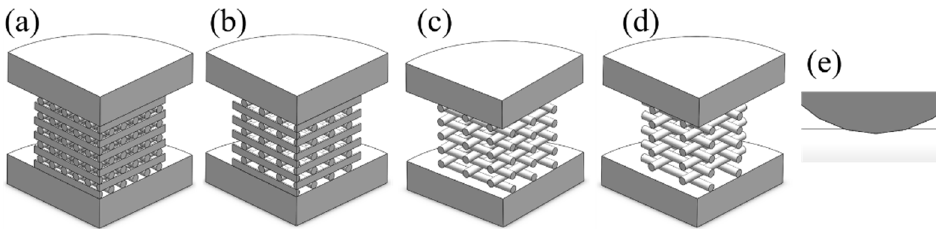
Figure 5. CAD models for the PCL scaffolds with filament distance of ( a ) 1 mm, ( b ) 1.5 mm, ( c ) 2 mm, and ( d ) 2.5 mm, respectively. ( e ) Overlapping of 0.01 mm between two adjacent layers.